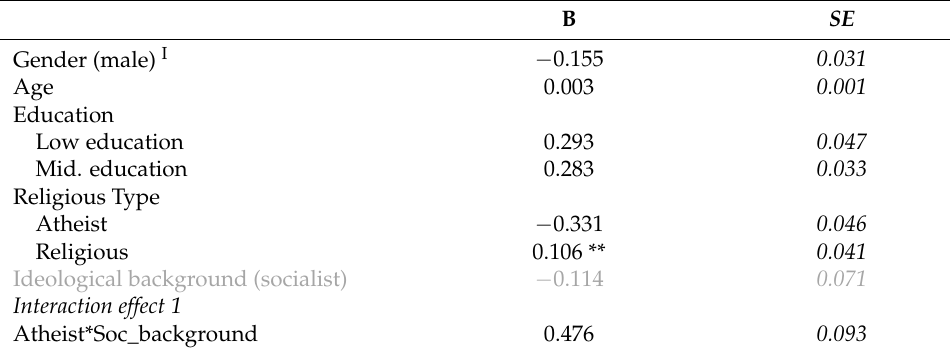
Table 2. Regression Analysis for the German